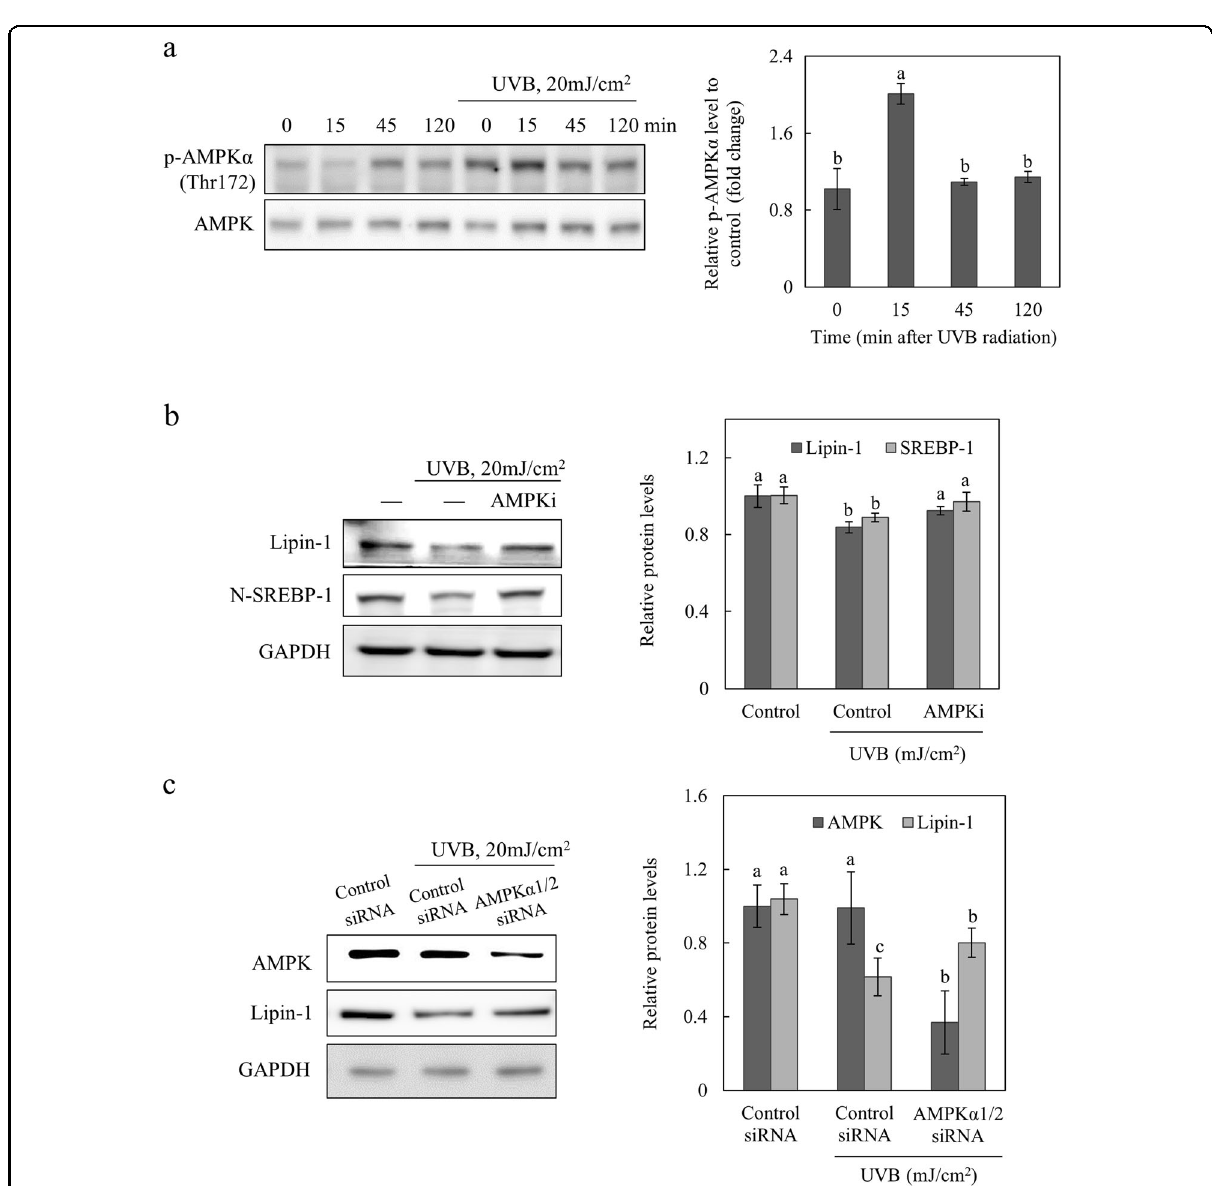
Fig. 3 The AMPK signaling cascade is responsible for UVB-induced lipin-1 inhibition. a NHEKs exposed to 20 mJ/cm 2 UVB were cultured for 0, 15, 45, and 120 min. The protein levels of p-AMPK α (Thr172) and AMPK were detected by western blotting. The levels of phosphorylated AMPK α (Thr172) were normalized to AMPK. Normalized p-AMPK levels relative to those of the control were analyzed at 0, 15, 45, and 120 min after UVB exposure. b NHEKs that were pretreated with the AMPK inhibitor (compound C, 10 μ M) for 15 min were exposed to 20 mJ/cm 2 UVB and incubated for 24 h. Lipin-1 or N-SREBP-1 levels were detected by western blotting and normalized to GAPDH. c NHEKs that were transfected with lipin-1 or control siRNA were exposed to 20 mJ/cm 2 UVB and incubated for 24 h. AMPK or lipin-1 levels were detected by western blotting and normalized to GAPDH. All data (mean± SD) represent three independent experiments. Means without a common letter differ; P <